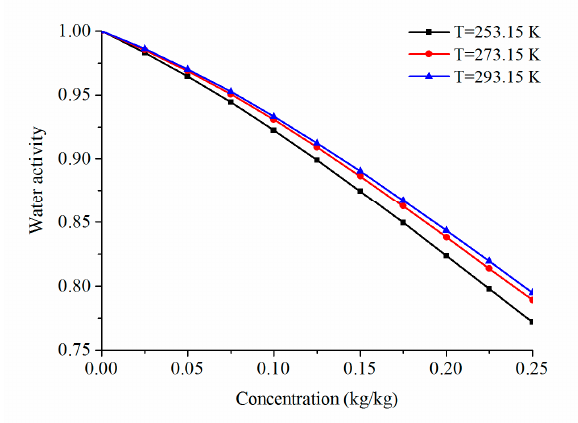
Figure 10. Influence of temperature and concentration on water